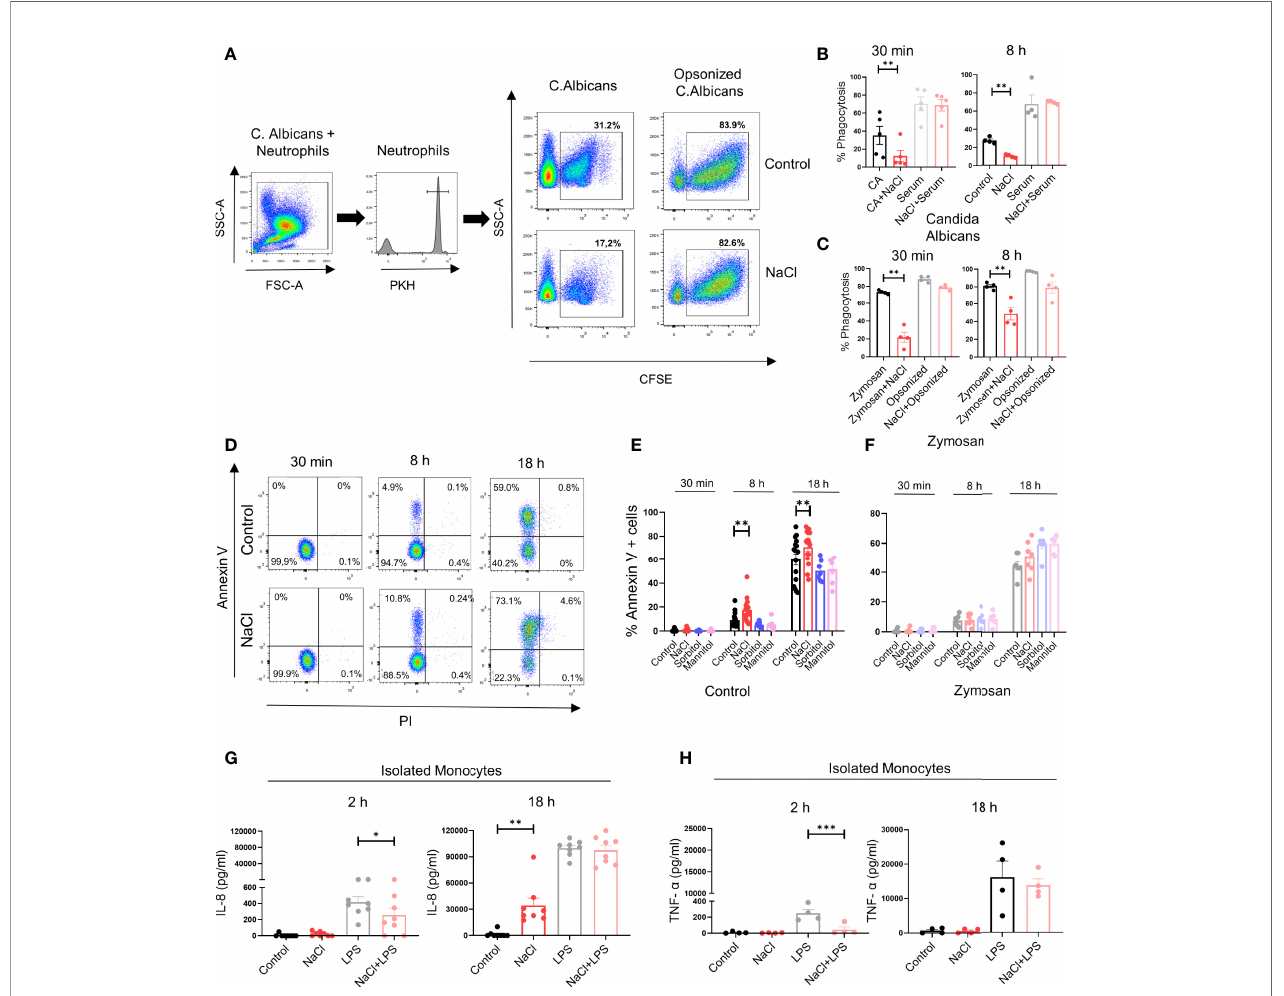
FIGURE 5 | Effect of high salt on neutrophil phagocytosis and the production of IL-8 and TNF- a by monocytes. (A) Neutrophils were labeled with PKH26 and incubated (2 x 10 6 neutrophils/ml) for 30 min in culture medium supplemented, or not, with NaCl (50 mM). Then, CFSE-labeled yeast ( C.albicans ) were added (neutrophil/yeast ratio of 1:1), in the absence or presence offresh autologous serum (10% v/v). After 40 min of incubation at 37°C, yeast phagocytosis was evaluated in the gate of neutrophils (PKH26 positive cells) by fl ow cytometry using trypan blue to quench the fl uorescence of the yeast attached (but not internalized) by neutrophils. A representative experiment and the mean ± SE from 5 experiments are shown. (B) Phagocytosis of C. albicans was evaluated as described in A, in neutrophils preincubated for 8 h in culture medium supplemented, or not, with NaCl (50 mM). Results represent the mean ± SE of 4 experiments. (C) Neutrophils (2 x 10 6 neutrophils/ml) were cultured for 30 min or 8 h in medium supplemented, or not, with NaCl (50 mM). Then, fl uorescent-labeled Zymozan particles (50 m g/ml) were added. After 1 h of incubation at 37°C, phagocytosis of Zymosan particles was evaluated by fl ow cytometry. Results are expressed as the mean ± SE from 4 experiments. (D) Neutrophils (2 x 10 6 /ml) were incubated at 37°C for 30 min, 8 h or 18 h in medium supplemented, or not, with NaCl (50mM). Then cells were labeled with annexin-V FITC and propidium iodide, and apoptosis was evaluated by fl ow cytometry. A representative experiment is shown. (E , F) Neutrophils (2 x 10 6 /ml) were incubated at 37°C for 30 min, 8 h or 18 h in medium supplemented, or not, with NaCl (50mM), sorbitol or mannitol (100 m), in the absence (E) or presence of Zymosan (F) . Then cells were labeled with annexin-V FITC and propidium iodide, and apoptosis was evaluated by fl ow cytometry. Results are expressed as the mean ± SE from 7-17 experiments. (G , H) Isolated monocytes (1 x 10 6 /ml) were incubated at 37°C for 2 or 18 h in culture culture medium supplemented, or not, with NaCl (50 mM) and/or LPS (100 ng/ml). Then, the production of IL-8 (G) and TNF- a (H) was evaluated in cell supernatants by ELISA. The mean ± SE from 4-8 experiments are shown. * P <.05, ** P <.01, and *** P